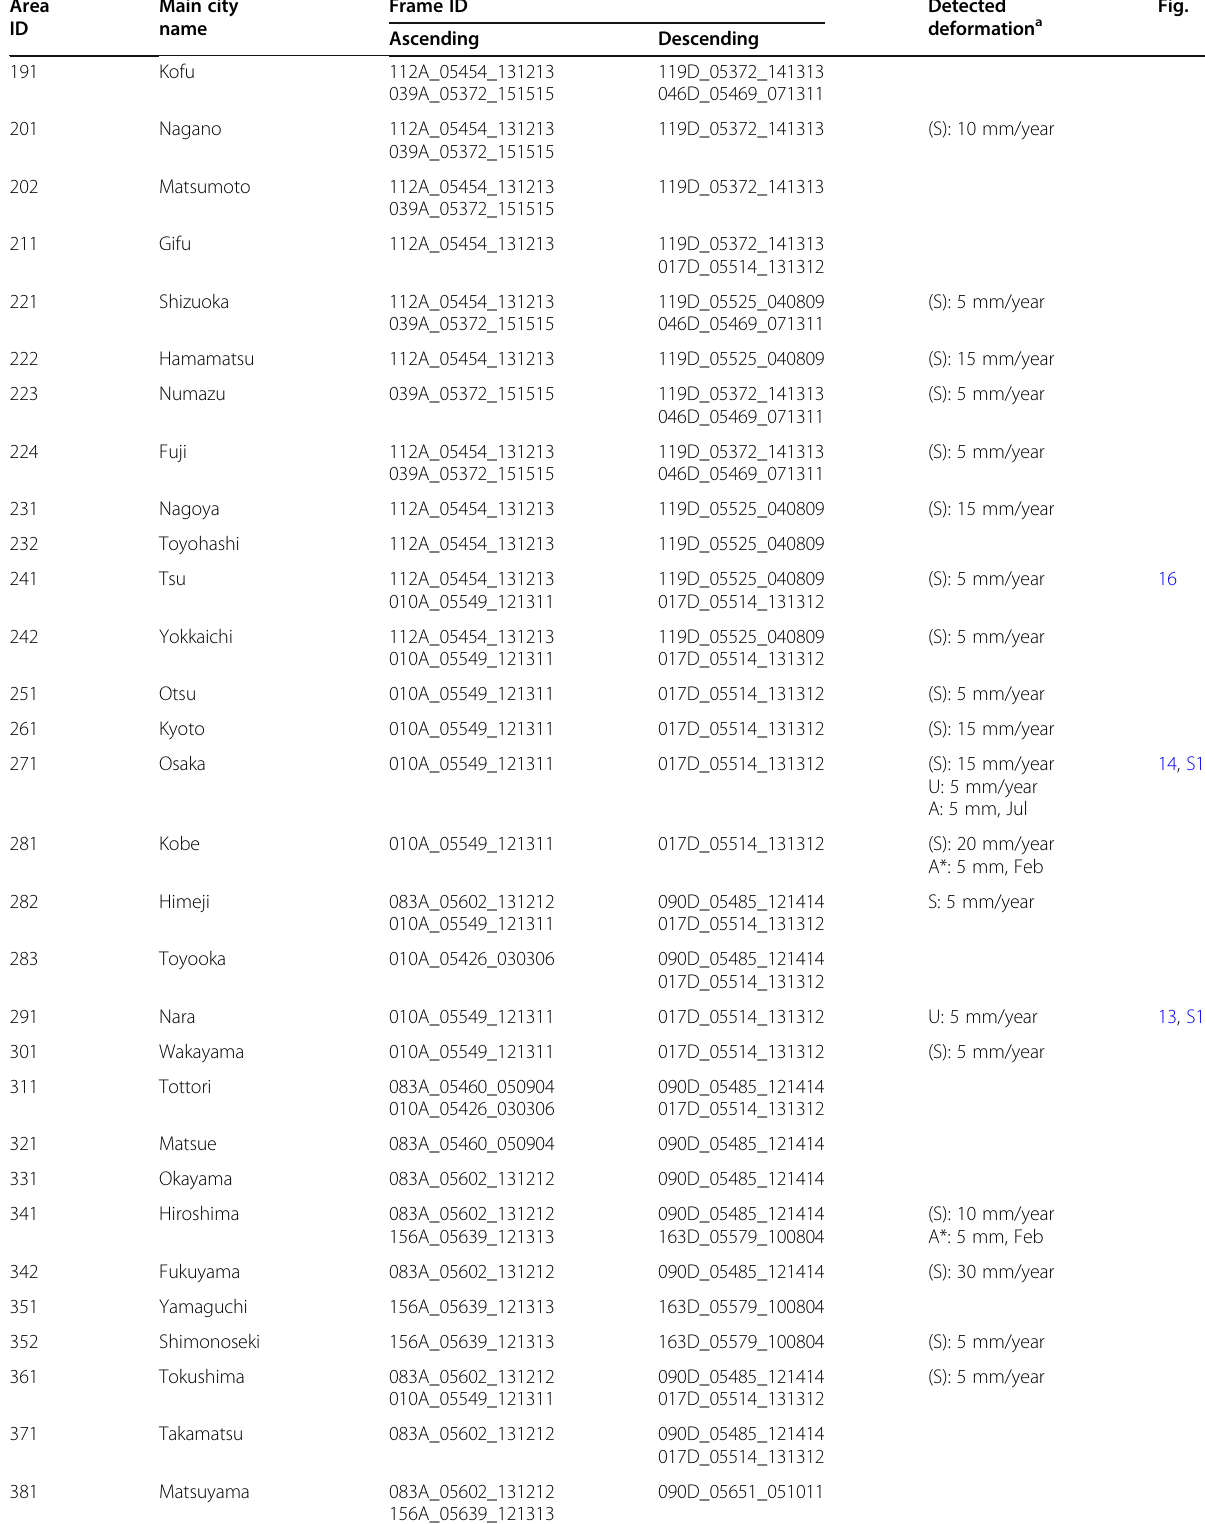
Table 2 Target urban areas, corresponding frame ID, and detected deformation signals